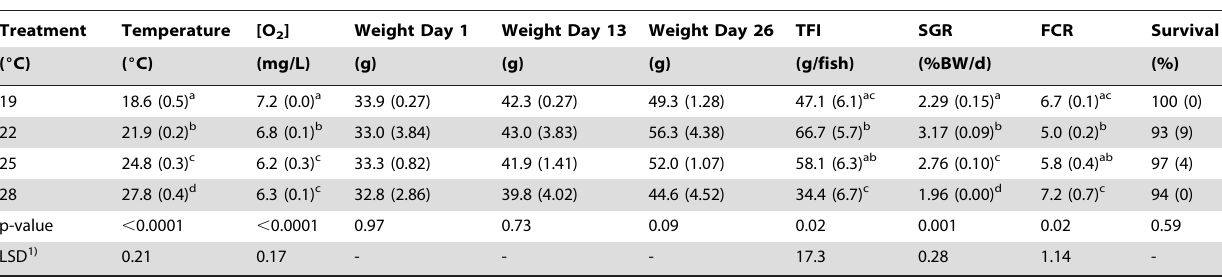
Table 3. Results of the growth experiment.